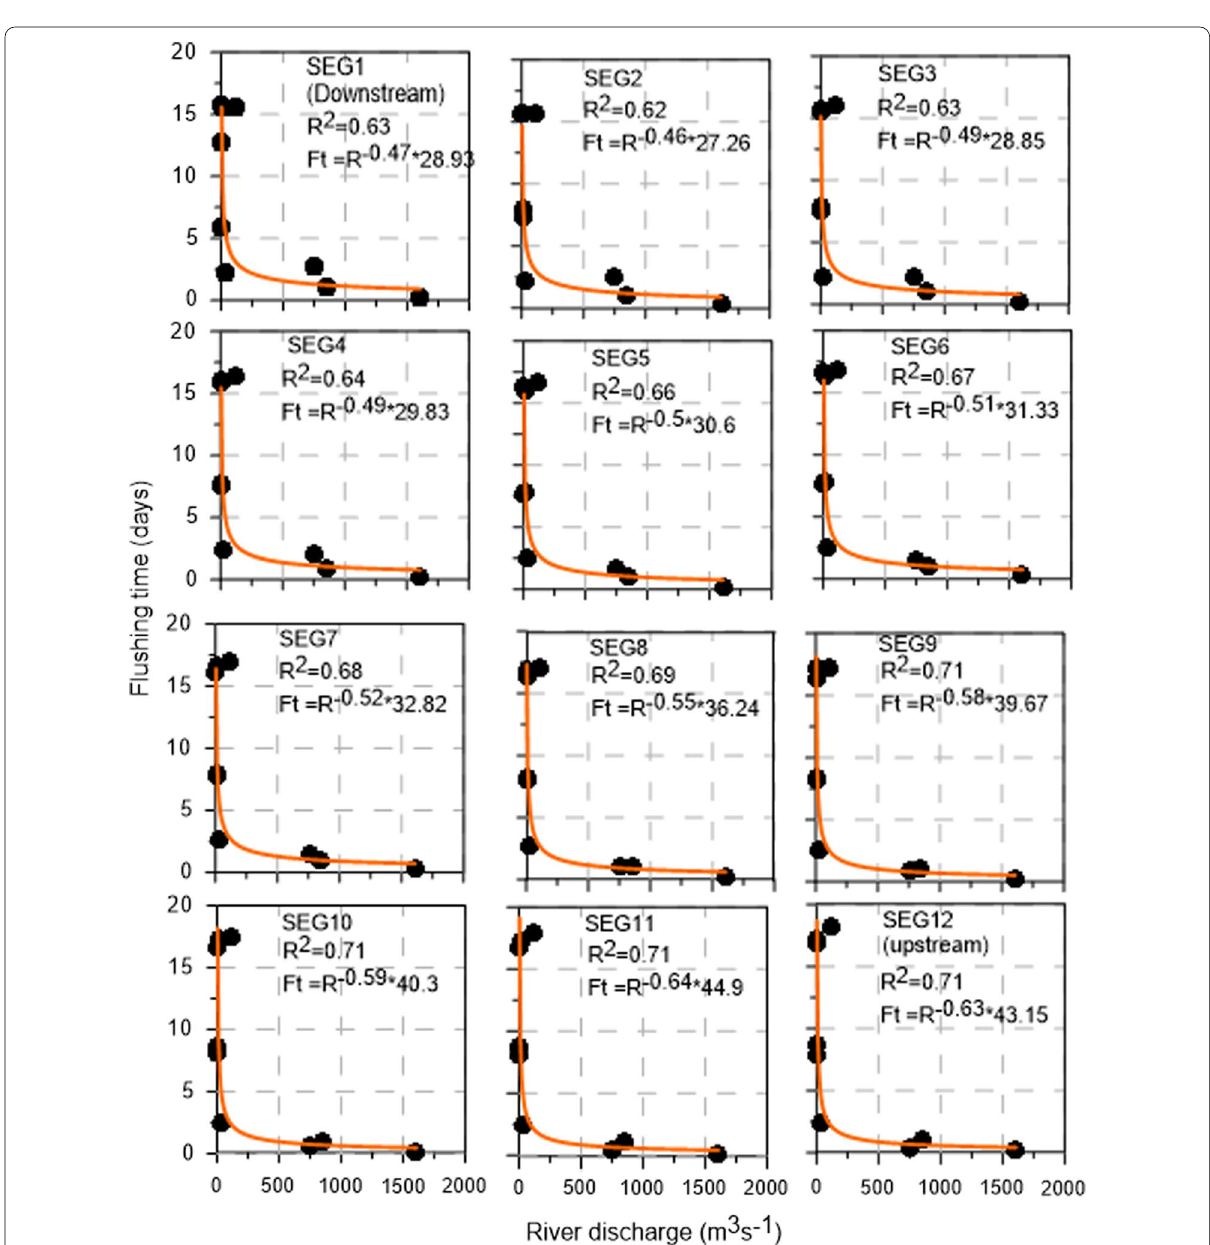
Fig. 9 Comparison of the power‑law relations between e‑folding flushing time (days) and river discharge (m 3 s − 1 ) for multiple estuarine